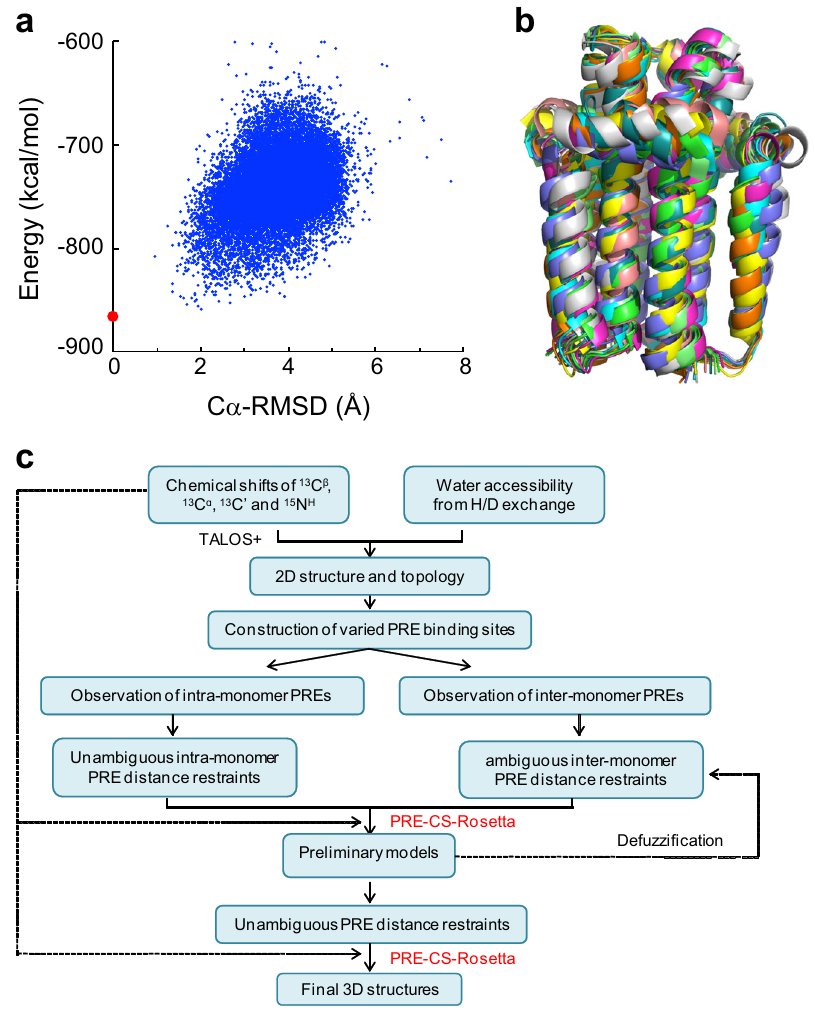
Fig. 6 Structure calculations using PRE-CS-Rosetta combined with intra- and inter-monomer distance restraints extracted from PRE measurements. a Plot of CS-Rosetta energy score versus C α -RMSD relative to the lowest energy structure (red dot) obtained using PRE-CS-Rosetta calculations. b An ensemble of 10 structures with the lowest energy from PRE-CS-Rosetta calculations. c The work fl ow of structure determination of membrane proteins by the PRE-CS-Rosetta